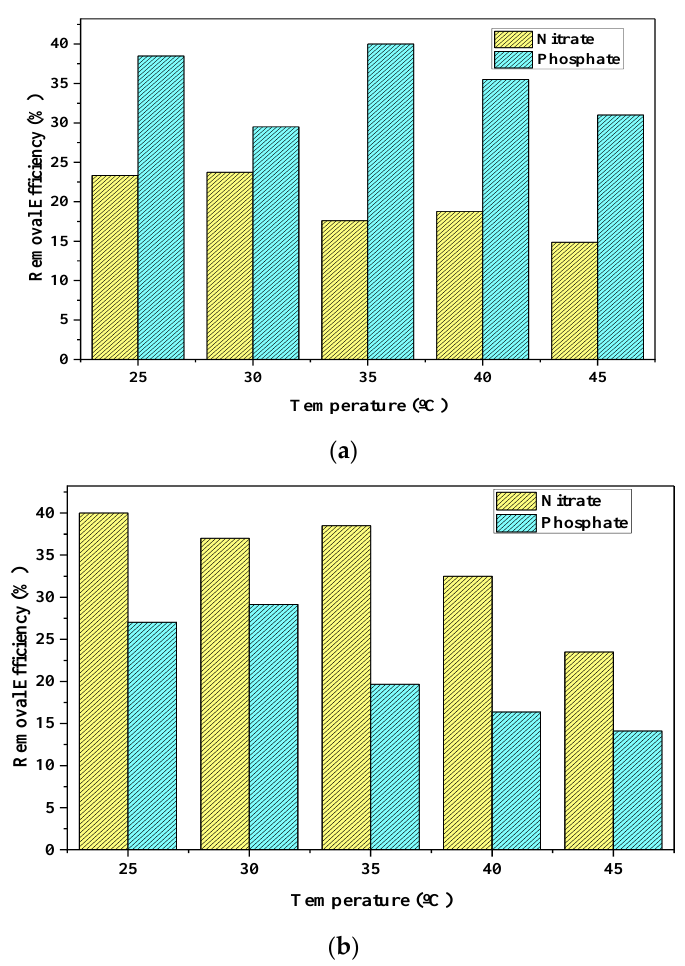
Figure 4. Nitrate and phosphate removal efficiency using bio-adsorbents prepared from corn stalks ( a ) modified cellulose (MC) with the chemical agent CTAC; and ( b ) biochar impregnated with sulfuric acid (B 1:1).